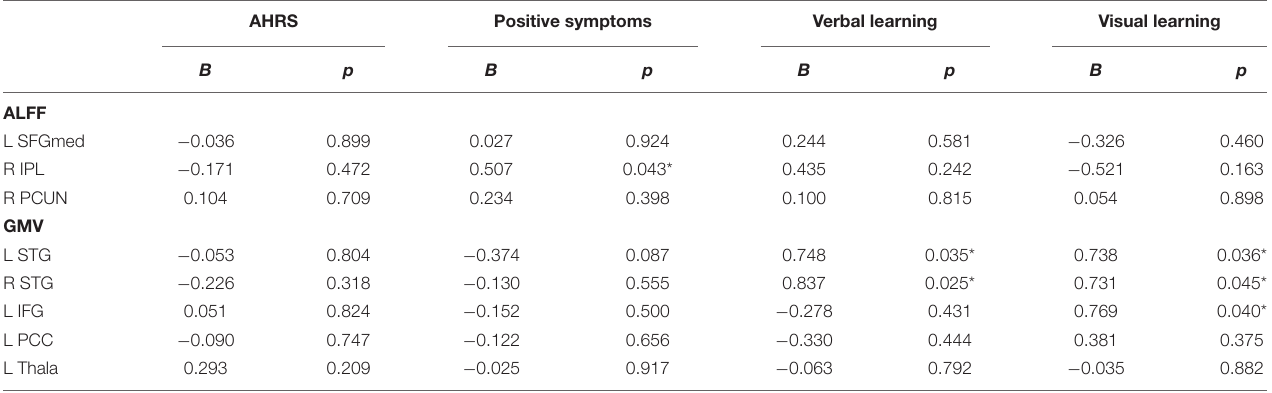
AHRS Positive symptoms Verbal learning Visual